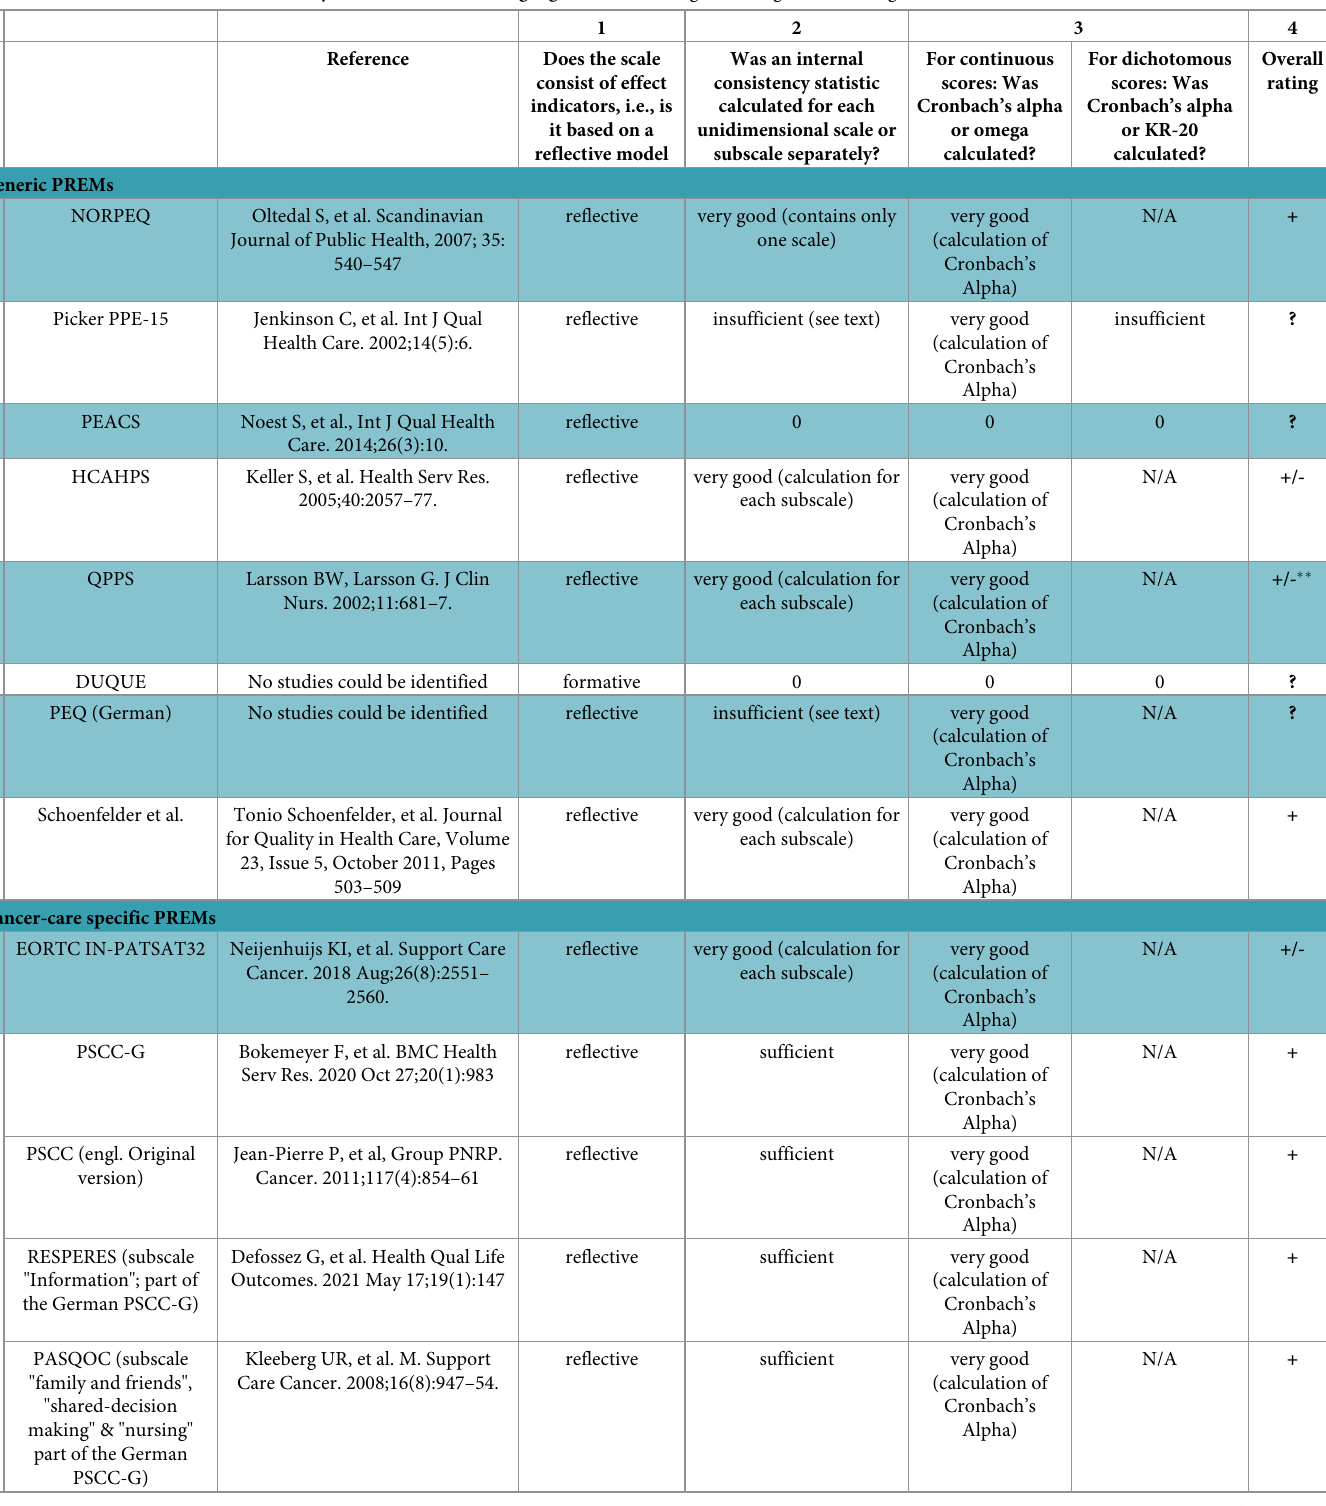
Table 6. Overview of internal consistency studies of German-language PREMs. Rating according to COSMIN